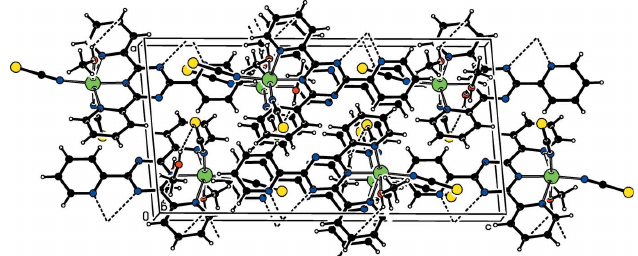
Figure 2 The packing in the crystal structure of the title compound, viewed approximately along the b axis. Hydrogen-bonding interactions are drawn as dashed lines.